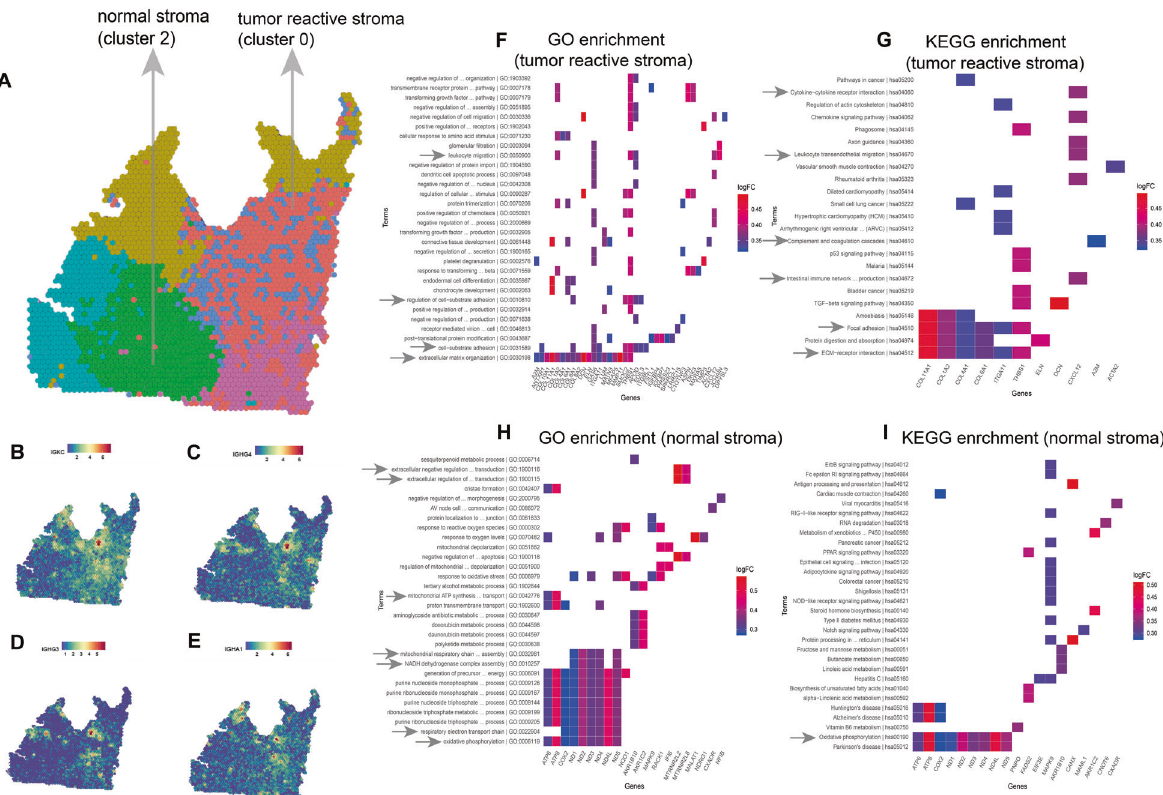
Fig. 4 The spatial distribution of stromal regions affects the gene expression of IMPC regions in sample 1. A The spatial distribution position of two stromal clusters (cluster 0 and 2). The stroma (green cluster) is far from IMPC regions (blue and pink clusters). Another stroma (red cluster) is near IMPC regions. B – E The expression level of IGKC , IGHG4, IGHG3 , and IGHA1 genes on the spatial plots. F, G The enrichment results of cluster 0 highly expressed top 50 genes on GO (BP) and KEGG. H, I The enrichment results of cluster 2 highly expressed top 50 genes on GO (BP), and KEGG. The arrows represent that these terms were linked to immune response, cellular interaction, complement pathway, and oxidative phosphorylation,